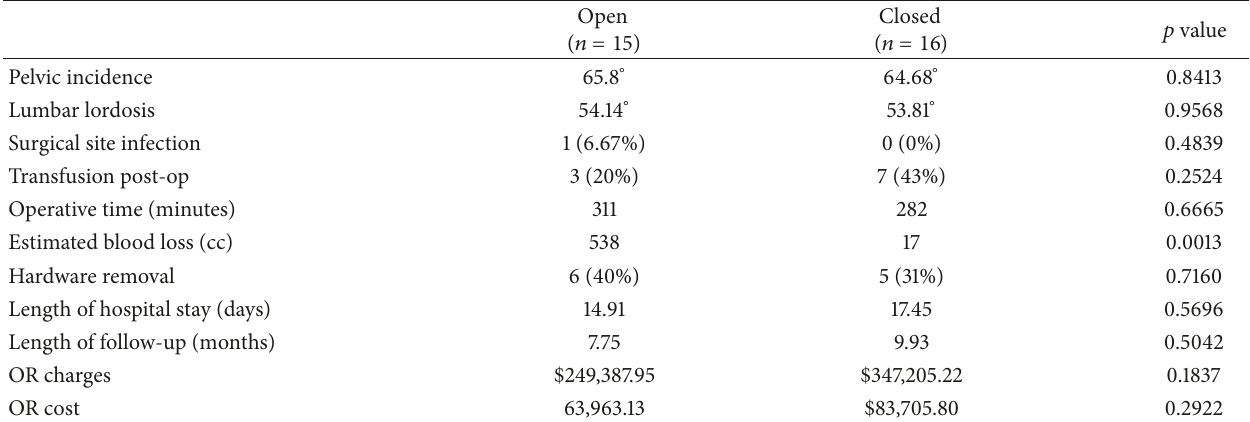
Table 4: Postoperative outcomes on operatively treated patients. Note that blood loss was statistically significantly less in the percutaneous